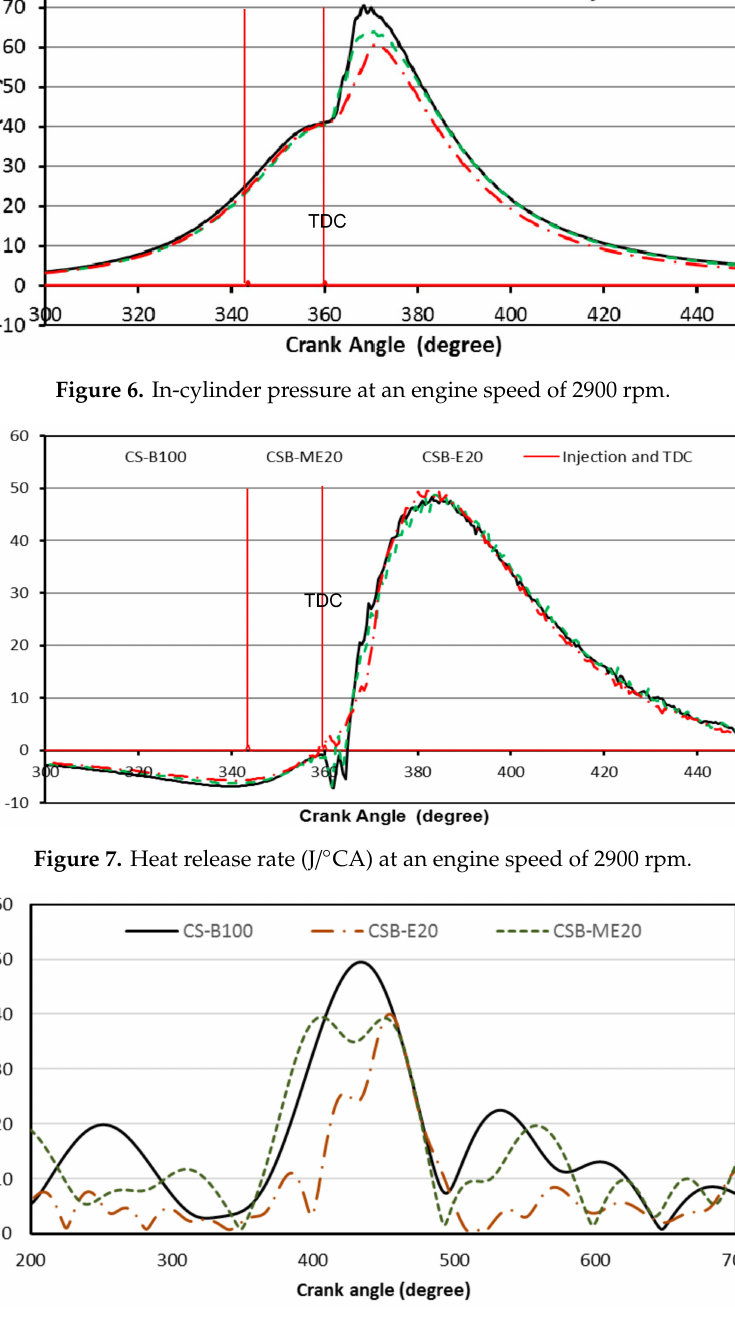
Figure 8. Vibration at an engine speed of 2900